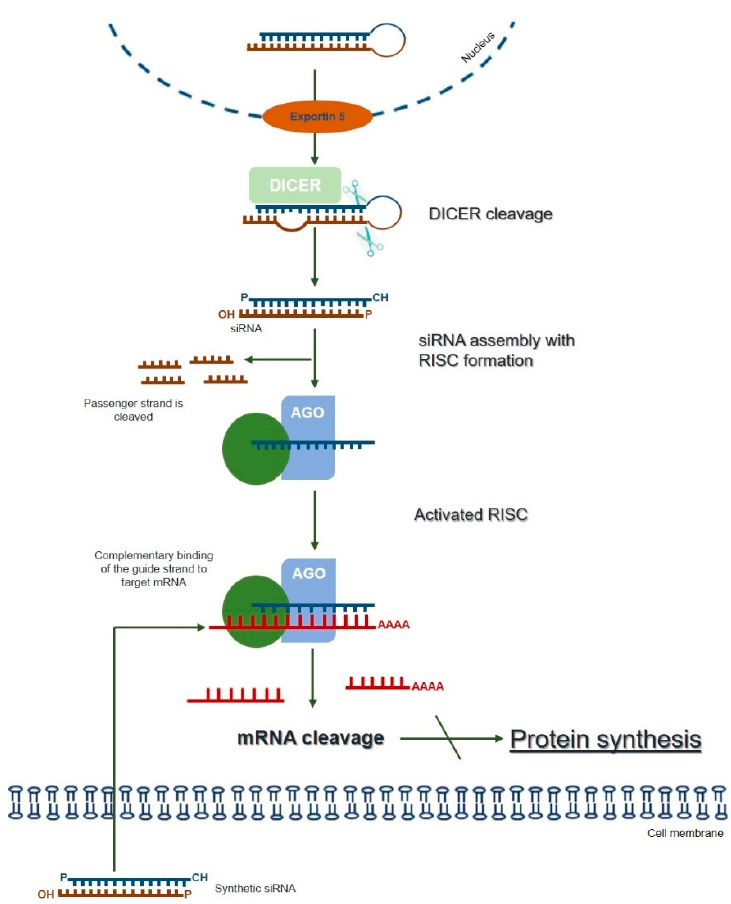
Figure 1. The mechanism of RNA interference (adapted from [7,73]). Long dsRNAs are produced within the nucleus and exported to the cytoplasm through exportin 5. Once they reach the cytoplasm, dsRNAs are cleaved by an enzyme called Dicer. The resulting fragments, consisting of a guide (antisense) strand and a passenger (sense) strand, are called small interfering RNAs (siRNAs). The siRNAs are then incorporated into the RNA-induced silencing complex (RISC), resulting in the cleavage of the sense strand of RNA by Argonaute 2 (AGO2), whereas the antisense strand guides RISC towards the complementary mRNA, which is cleaved into two mRNA fragments leading to the silencing of the target gene. The activated antisense–RISC complex can then be recycled for degradation of additional target mRNA molecules (see text for details). The RNAi-mediated gene-silencing can be triggered by synthetically produced siRNAs directly introduced into the cell, circumventing the Dicer-cleavage step. This shortcut reduces the potential for an innate immune interferon response.